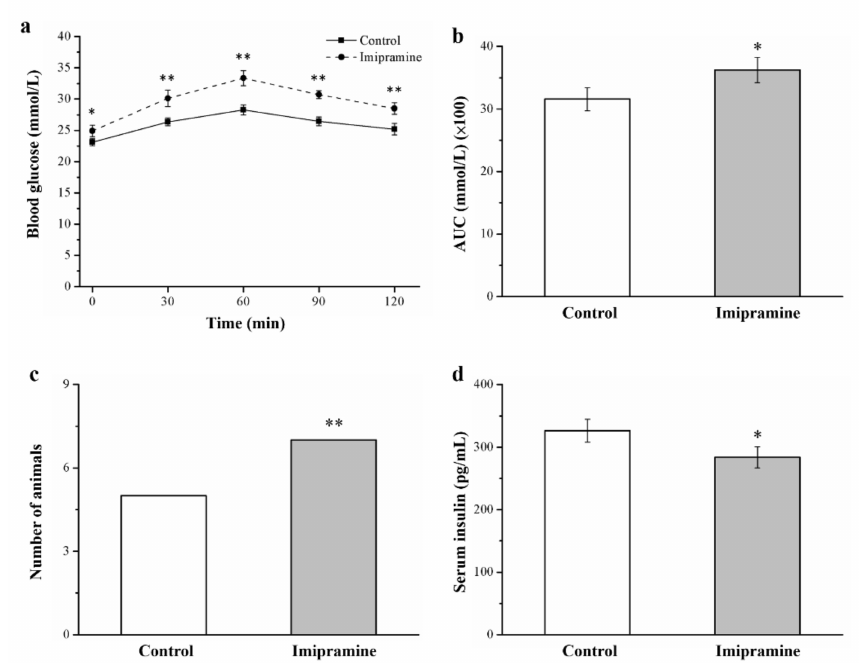
Figure 6. Impact of imipramine on ( a ) blood glucose tolerance score. ( b ) Area under the curve (AUC) at 120 min post-glucose injection of blood glucose levels. ( c ) Glucose intolerance (Fisher’s exact test). ( d ) Serum insulin levels. Data are in the form of mean ± standard deviation ( n = 8). * p < 0.05; ** p <